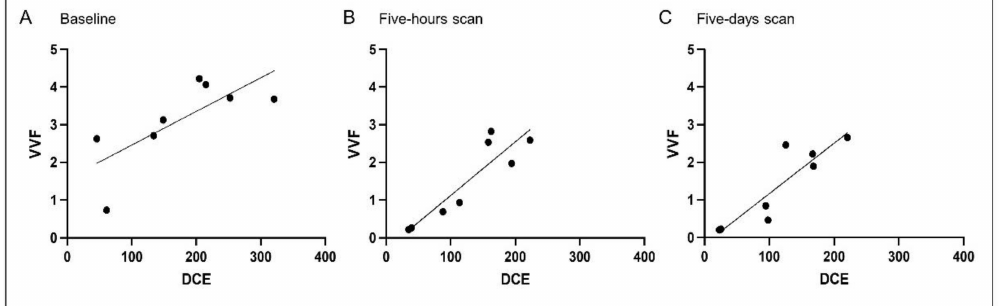
Figure 4. Correlation between imaging parameters DCE and VVF before and after therapy with tTF-NGR. Correlation of the values of DCE and VVF over the first cycle of tTF-NGR therapy visualizes that either value can be used for assessment of perfusion after treatment targeting the tumor vasculature, for the pre-scan ( A ), as well as for the scan after five hours ( B ) and five days ( C ). Spearman two-tailed correlation revealed a significant correlation between the respecting values over the entire course of the first cycle (baseline scan r = 0.046, p = 0.046, five-hours scan r = 0.881, p = 0.007, five-days scan r = 0.881, p = 0.007).